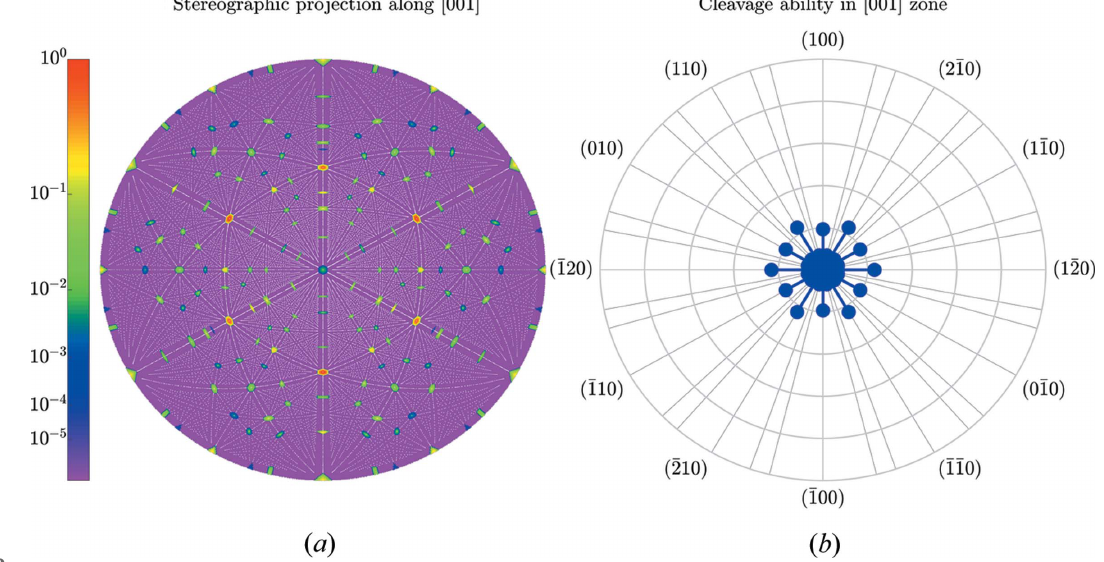
Figure 12 Same as Fig. 5 but for the [001] direction in quartz. The outer circle in ( b ) corresponds to the highest cleavage ability C 011 = 0.714 A˚ . Uriel Vaknin et al. (cid:5) Geometrical prediction of cleavage planes in crystal structures